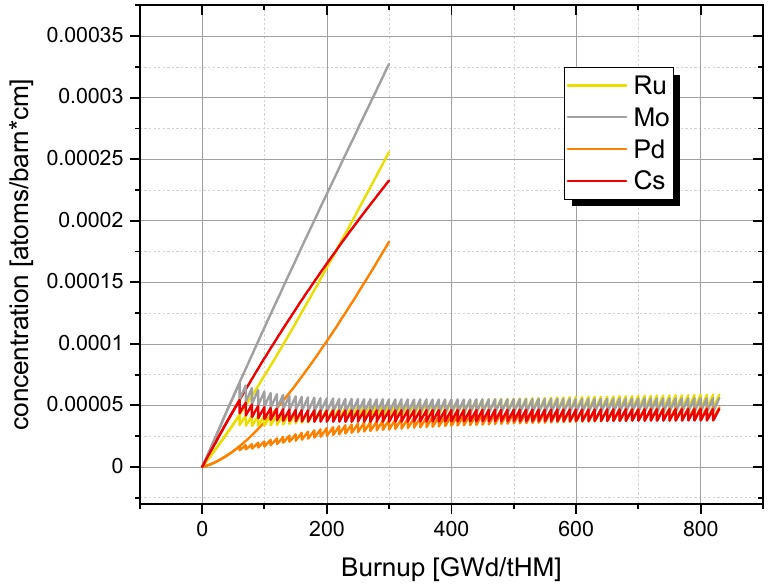
Figure 10. Development of the fission product elementary content over burnup as produced in HELIOS, considering the stepwise separation of different elements at 50 GWd/tHM with a 20% rate of salt being cleaned every step, based on a simulation using 10 GWd/tHM steps.